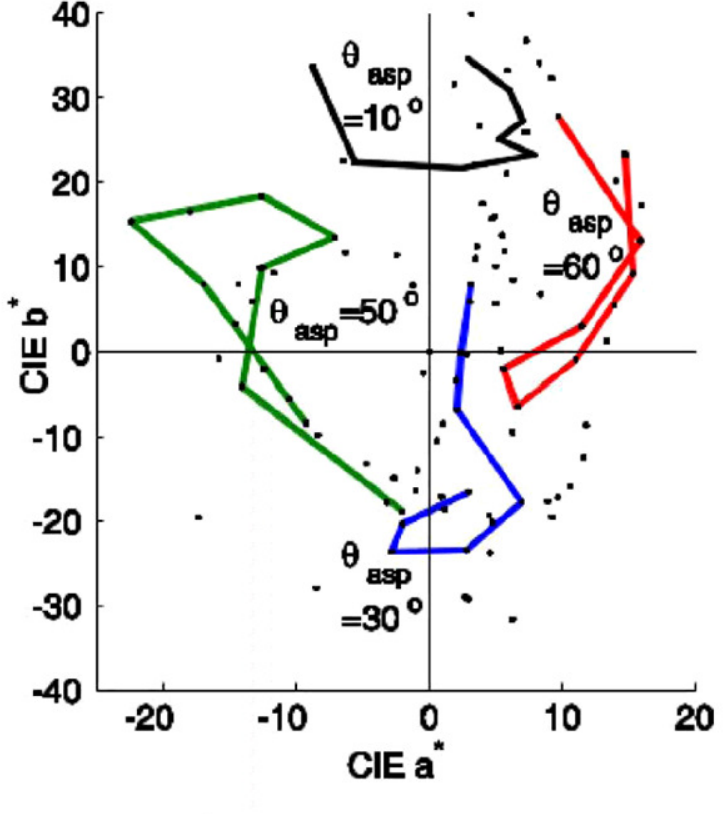
Figure 2. Color shift of a highly goniochromatic diffraction-based special effect coating (reprinted with permission from [15] c (cid:13) The Optical Society). Solid lines represent Bidirectional Reflectance Distribution Function (BRDF) measurements on the incidence plane, whereas dots represent out-of-plane